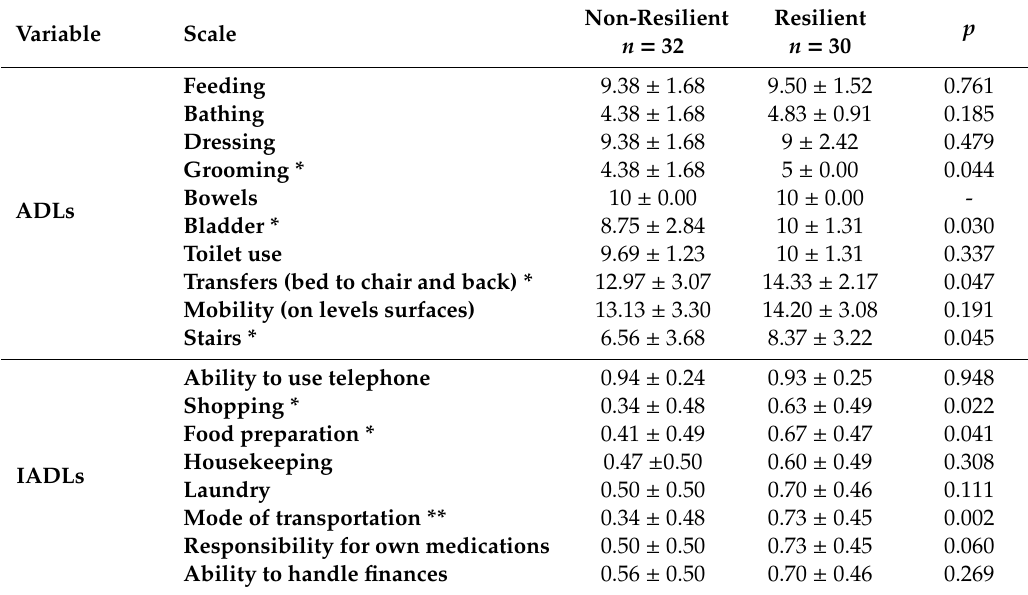
Table 3. Di ff erences in each domain of ADLs and IADLs between resilient and non-resilient participants (* p < 0.05; ** p < 0.01).